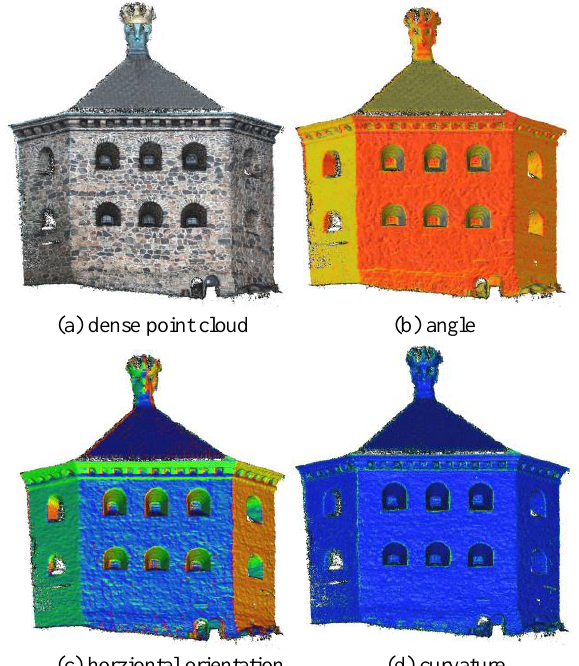
Figure 6 . Dense point cloud and visualized 3D pose-varied semantics of the building.